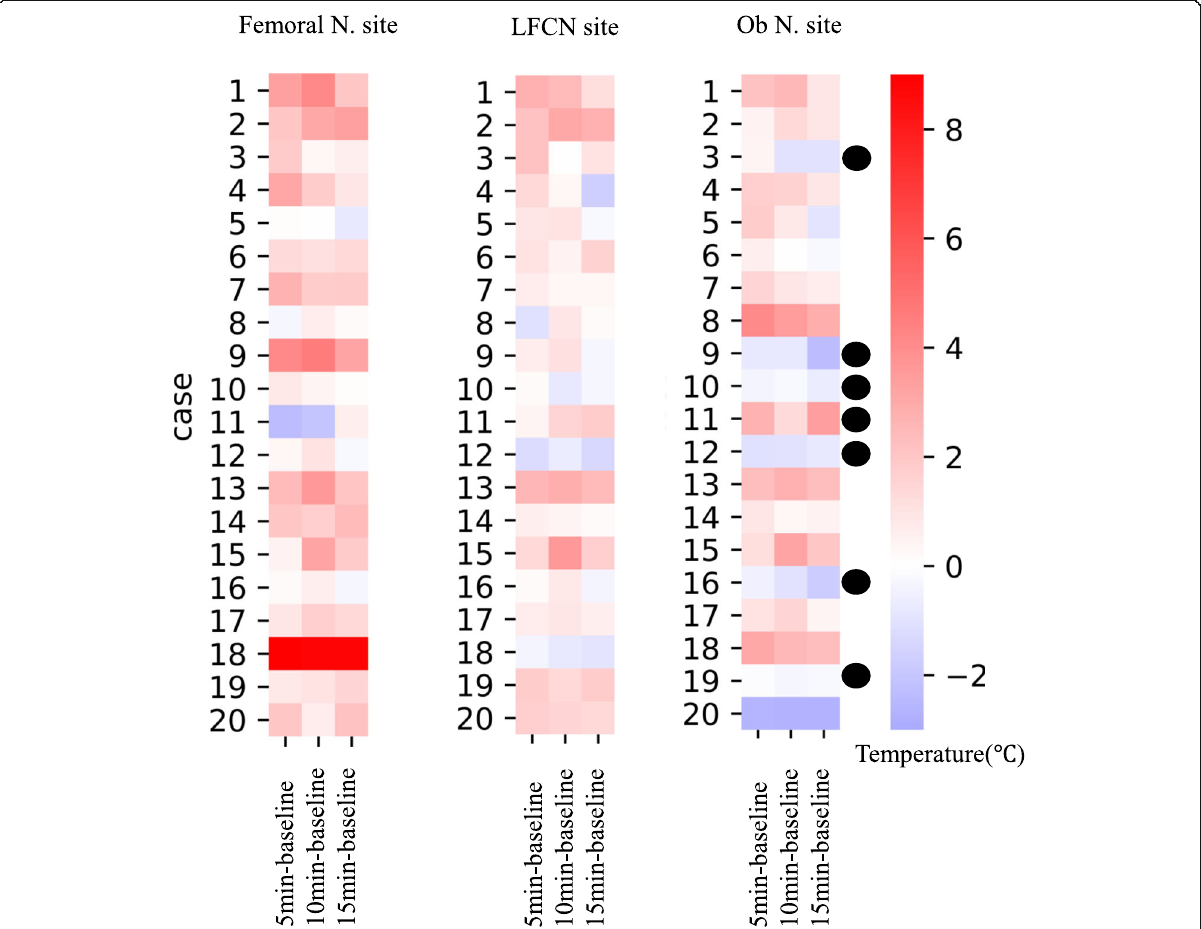
Fig. 4 Heat maps for each site. A temperature increase of >0°C was defined as the success between baseline and 5, 10, or 15 min. The sensitivity and specificity of the temperature increase to the cold loss were 96% and 63%, respectively. Black circle, no cold loss; LFCN, lateral femoral cutaneous nerve; Ob, obturator